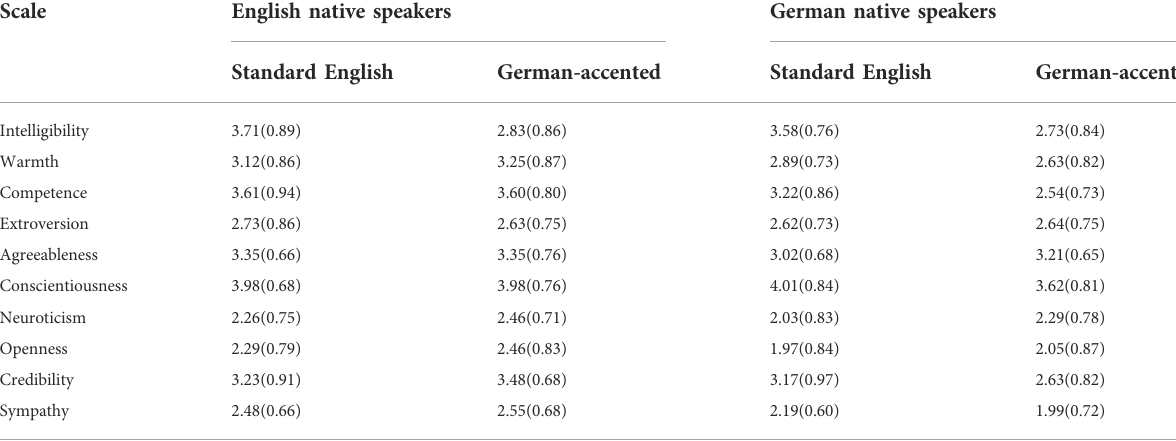
TABLE 1 Means for questionnaire measures for the respective groups and conditions. SDs in